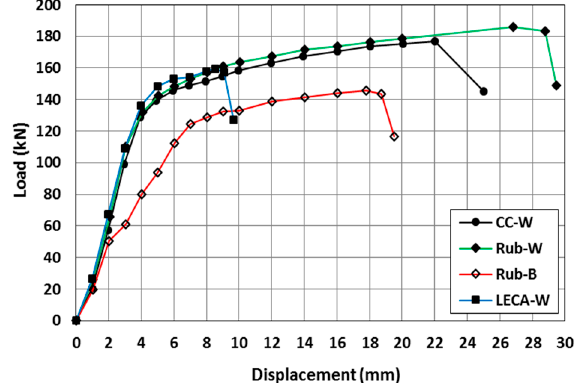
Figure 7. Backbone curves for tested specimens.